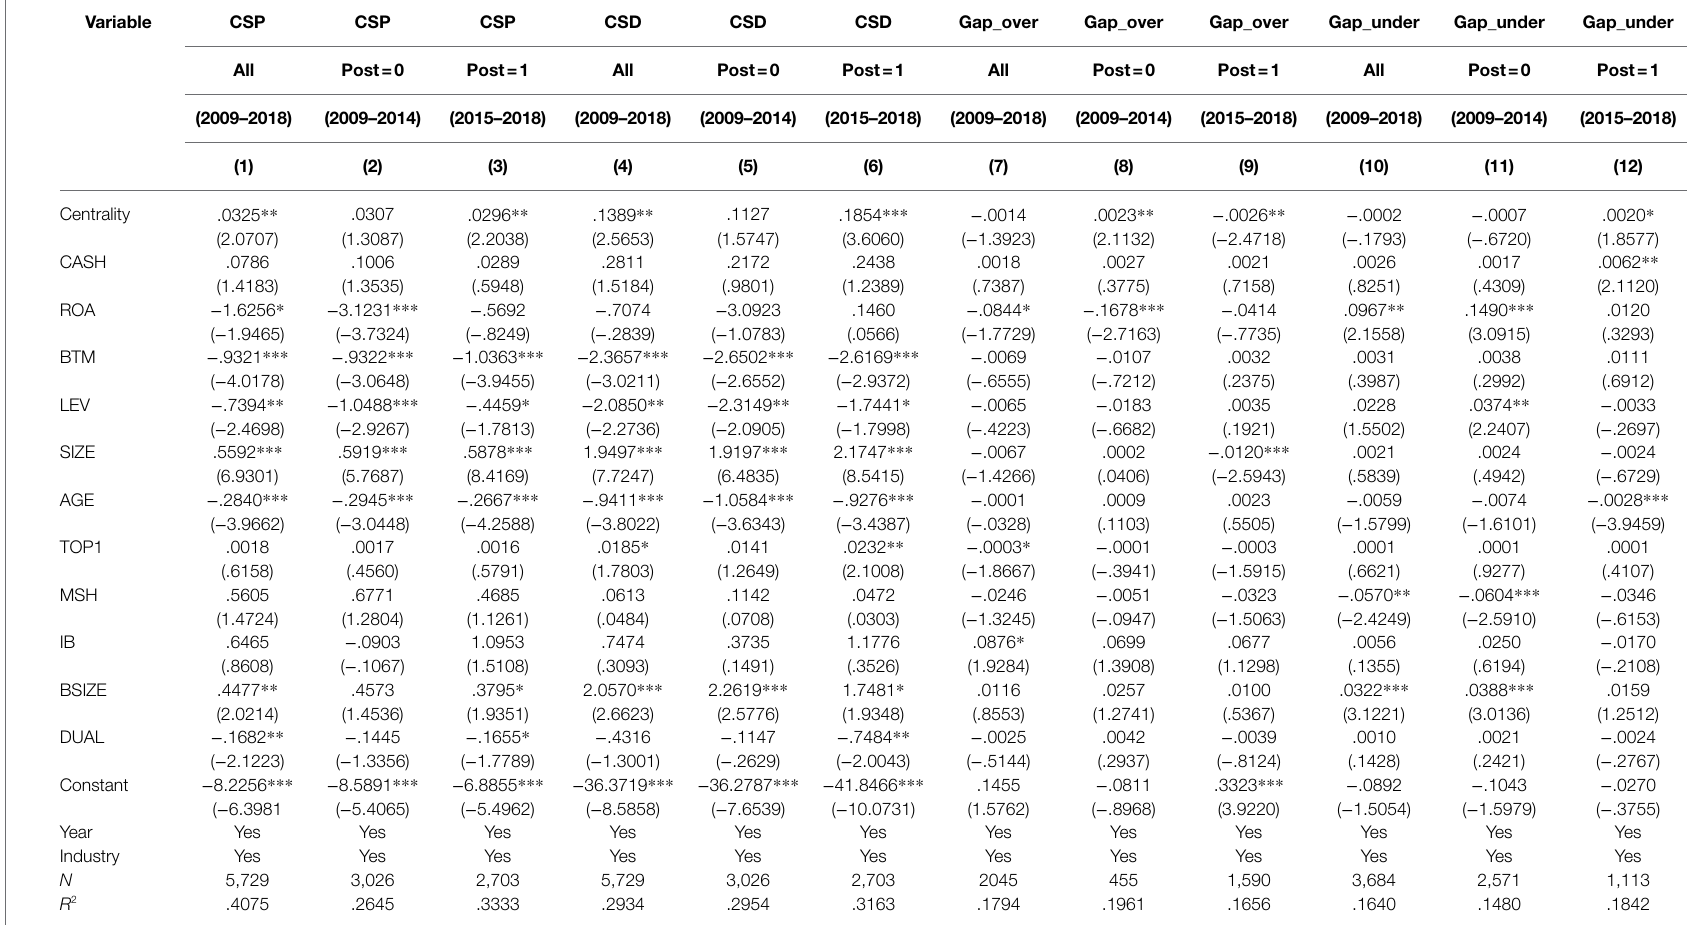
TABLE 3 | Regression results of board network centrality and CSP/CSD/Gap.